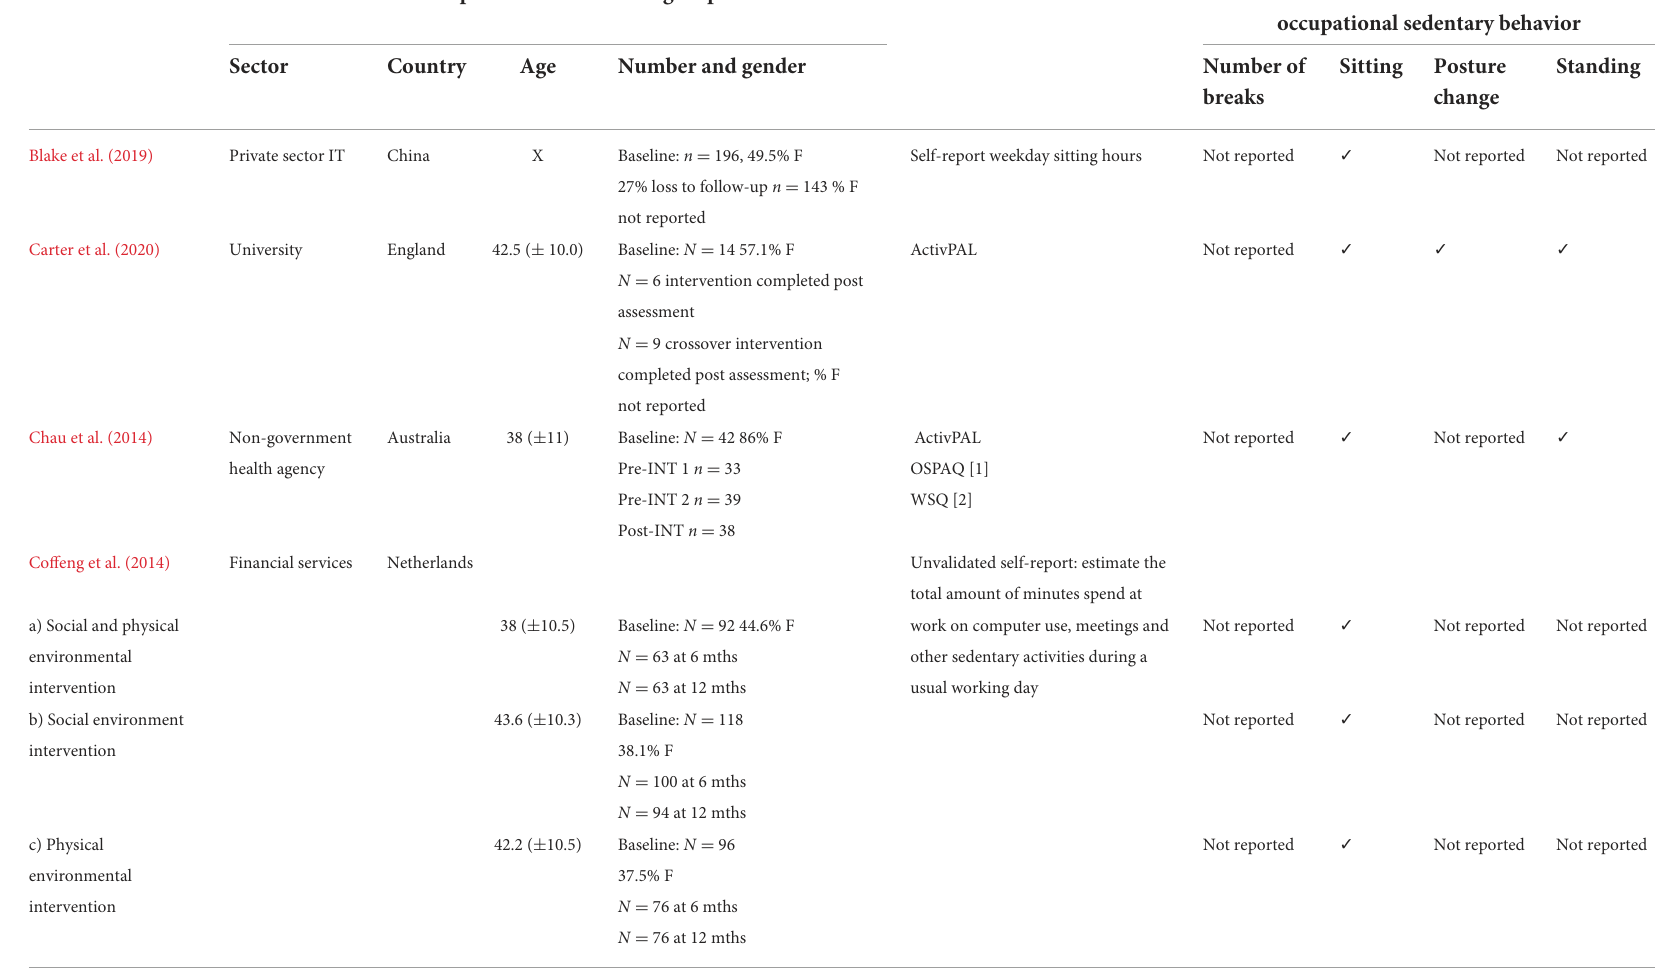
TABLE 2 Characteristics of included studies showing a beneficial direction of